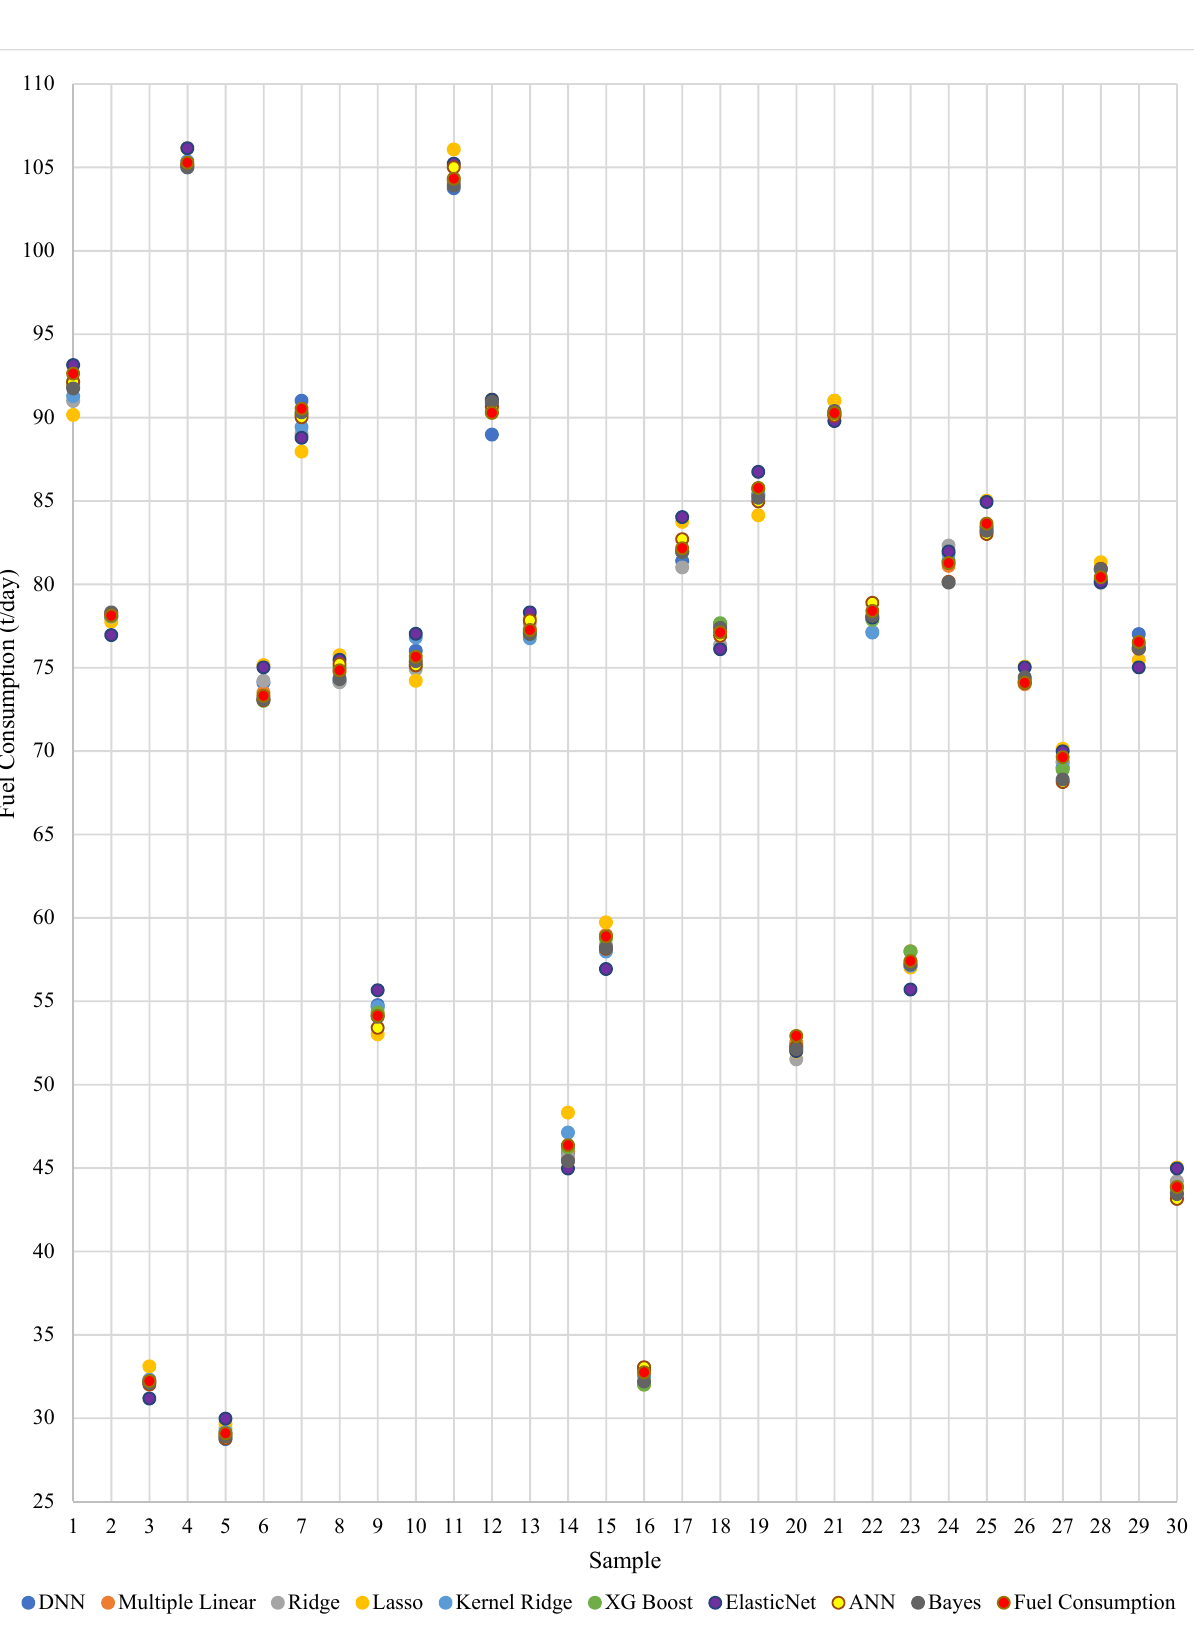
Figure 9. Comparison of fuel consumption with predictions.